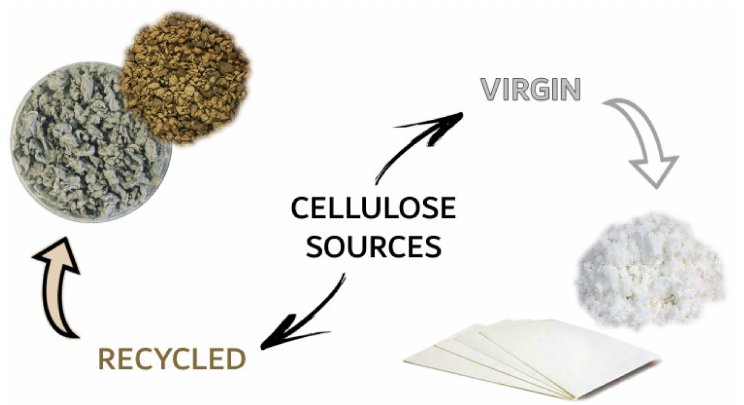
Figure 1. Cellulose sources considered for the production of cellulose nanofibers.